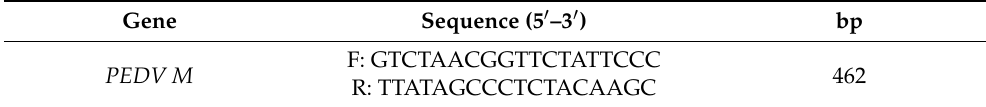
Table 1. Primer sequences for the PEDV M